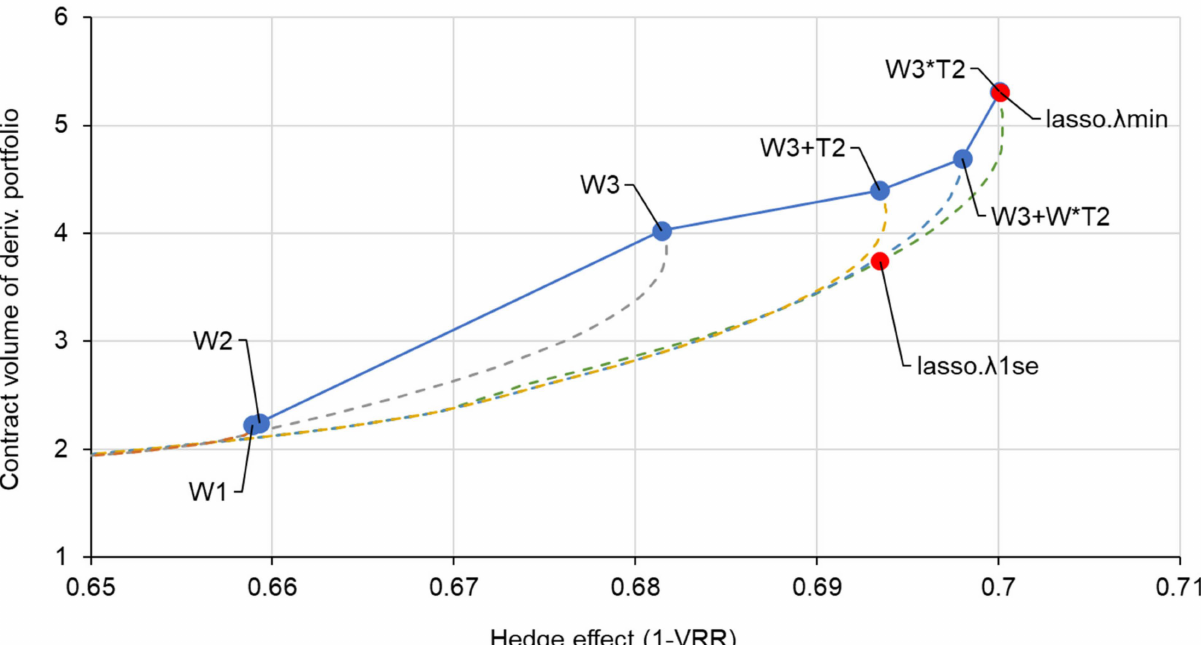
Figure 7. Relationship between contract volume and hedge effect by hedging model. Note: the term “lasso” refers to the W3*T2 model estimated by LASSO regression. Hedge effect is measured in out-of-sample periods. Note: the blue dots represent the estimation results from OLS and the dashed curves represent the estimation results obtained by varying λ in the LASSO